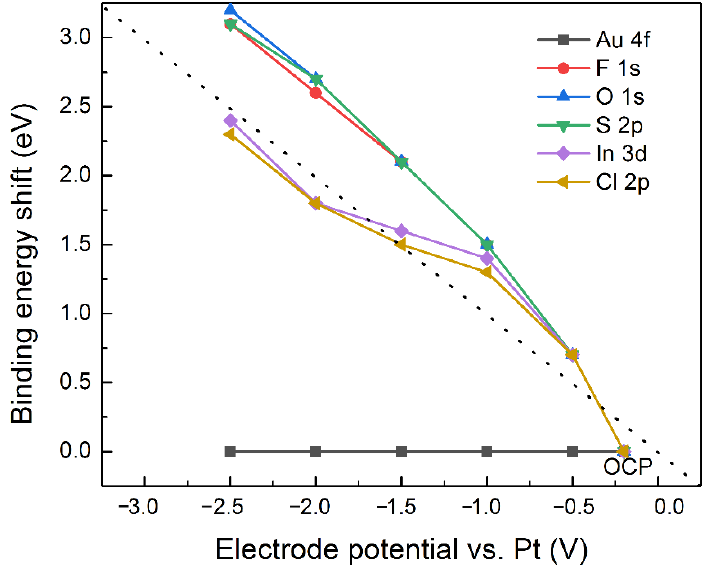
Figure 7. The plot of binding energy shifts of the components and the applied voltage. The deconvolution of the In 3d XPS spectra at − 2.0 V and at − 2.5 V is shown in Figure 8. At − 2.0 V, the spectrum is deconvoluted into three couples. The couple (green peaks) at 447.2 eV and 454.7 eV is attributed to In(III) 3d 5/2 and In(III) 3d 3/2 in the bulk, respectively. The couple (cyan peaks) at 445.8 eV and 453.2 eV is due to electrochemical reduced In(I), which is adsorbed on the gold surface. The couple (red peaks) is assigned to metallic indium, which is found at 444.2 eV and 451.7 eV. When the potential shifts to − 2.5 V, the In spectrum can also be deconvoluted into three couples. The bulk In(III) couple shifts to 447.9 eV and 455.3 eV (green curves). The adsorbed In(I) couple (cyan curves) almost do not shift their positions. In addition, the intensity of In(III) decreased and the intensity of In(I) increased when the voltage changed from − 2.0 V to − 2.5 V. The results suggest the reduction of In(III) to In(I). At − 2.5 V, the BEs of metallic indium are found at 444.0 and 451.5 eV. We attribute the formation of metallic indium at these potentials to the electrodeposition process and the disproportionation reaction of In(I) to In(III) and In(0). After electrodeposition, the in situ electrochemical cell was taken out from the XPS chamber and washed with acetone to remove the IL. The whole process took less than 10 s, in order to reduce the oxidation process. The chemical composition of the deposit was subsequently analyzed by ex situ XPS. Figure 9 represents the XPS detailed spectra of In 3d, Au 4f, O 1s, and Cl 2p of the In deposits. In the In 3d regime, the peaks at 444.1 eV and 451.6 eV are assigned to metallic indium and the peaks at 446.1 eV and 453.5 eV are attributed to indium oxide or adsorbed InCl 3 . The Au 4f peaks at 84.2 eV and 87.9 eV, which is +0.2 eV higher than that of metallic Au, are attributed to the formation Au-In alloy or oxidized alloy products